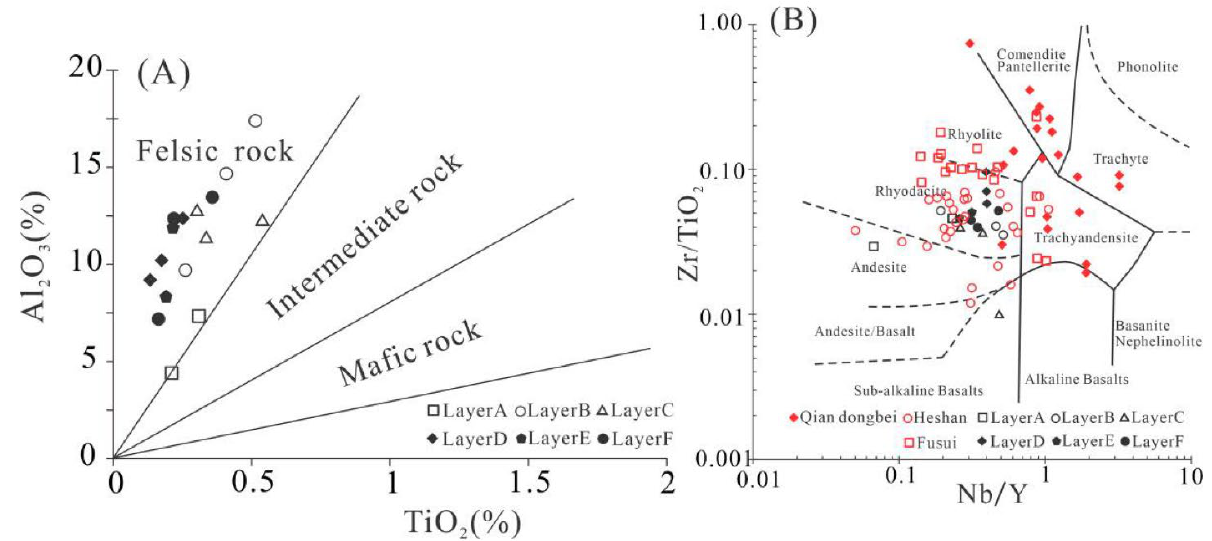
Figure 11. ( A ) the plot of Al 2 O 3 versus TiO 2 contents for the investigated samples; ( B ) the plot of Zr/TiO 2 versus Nb/Y contents for the investigated samples, the data of Qiandongbei [31], Heshan [3], and Fusui [5] are cited to compare.